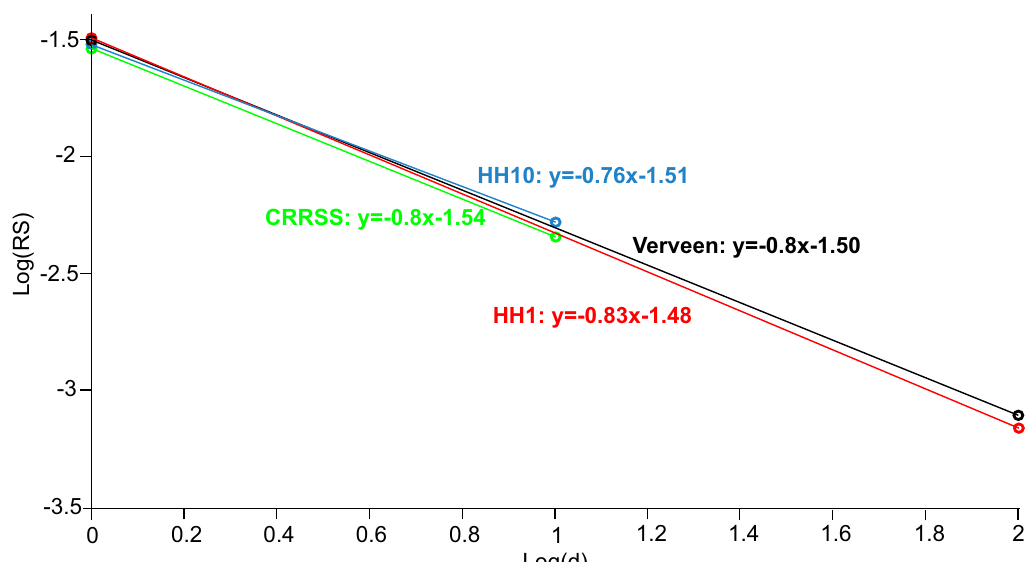
Fig 5. Comparison of HH10, HH1, and CRRSS at adjusted knoise with Verveen’s formula (black). The CRRSS model of the myelinated fiber with knoise = 0.0038 (green) shows exactly the same slope of the straight line as Verveen, but slightly underestimates the vertical displacement. The HH10 model (knoise = 0.00042) of the myelinated fiber (blue) and the HH1 model (knoise = 0.0038) of the unmyelinated fiber (red) show slight deviations in slope and vertical displacement. Myelinated axon models were calculated with idealized internodes assuming G m = 0 and C m = 0 in Fig 2B.